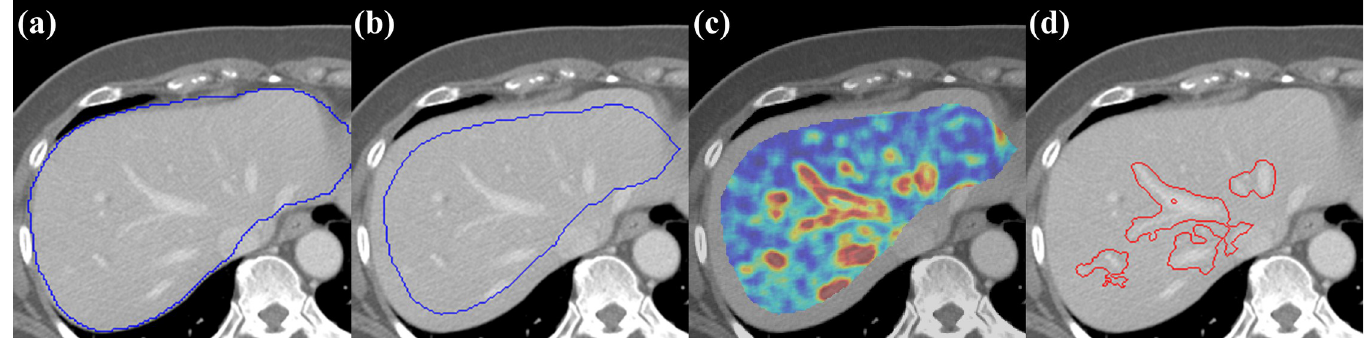
Fig 2. (a) A sample image of which the image quality being assessed with candidate region (liver parenchyma) segmented by using U-net deep-learning model, (b) Eroded mask from candidates with a structural element of 7 pixels, (c) SCF heat map calculated on the eroded mask, and (d) structural transition regions where the edge sharpness being quantified.